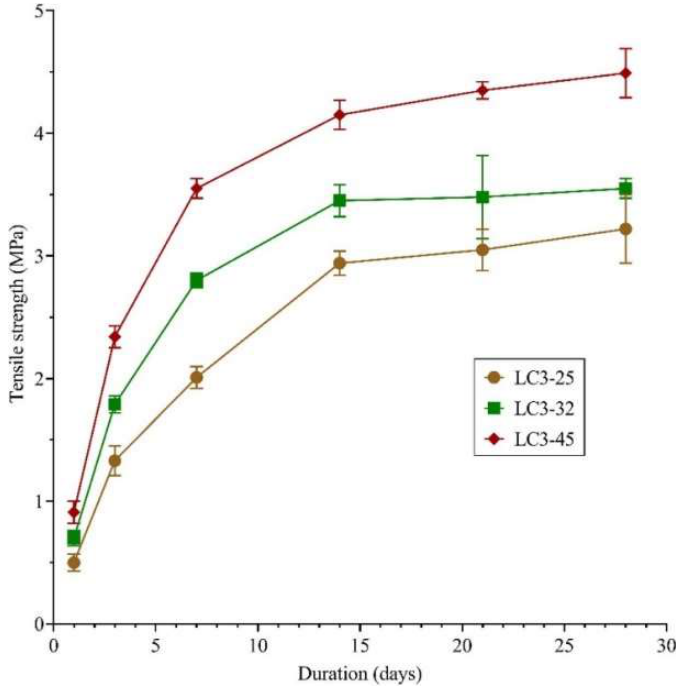
Figure 11. Change of tensile strength with time in LC3 concrete [75].